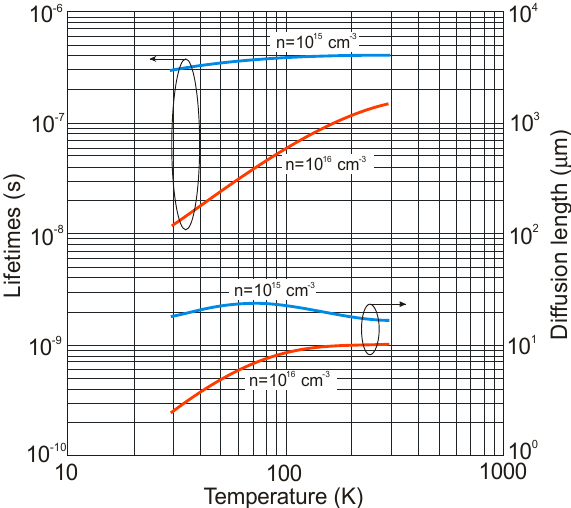
Figure 19. Simulated minority carrier lifetime and diffusion length versus temperature for holes in n-